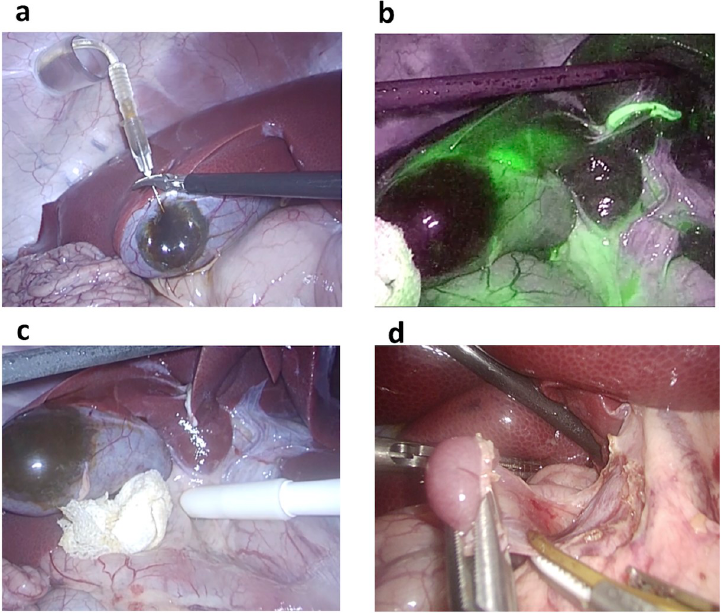
Fig 4. Laparoscopic sentinel lymph node (SLN) detection with a mixed tracer. ( a ) Injection of the mixed tracer into the gallbladder wall. ( b ) Indocyanine green fluorescence signals identified with near-infrared electronic laparoscopy. ( c ) Magnetic field evaluation with the laparoscopic magnetic probe. ( d ) Resection of the regional lymph nodes.